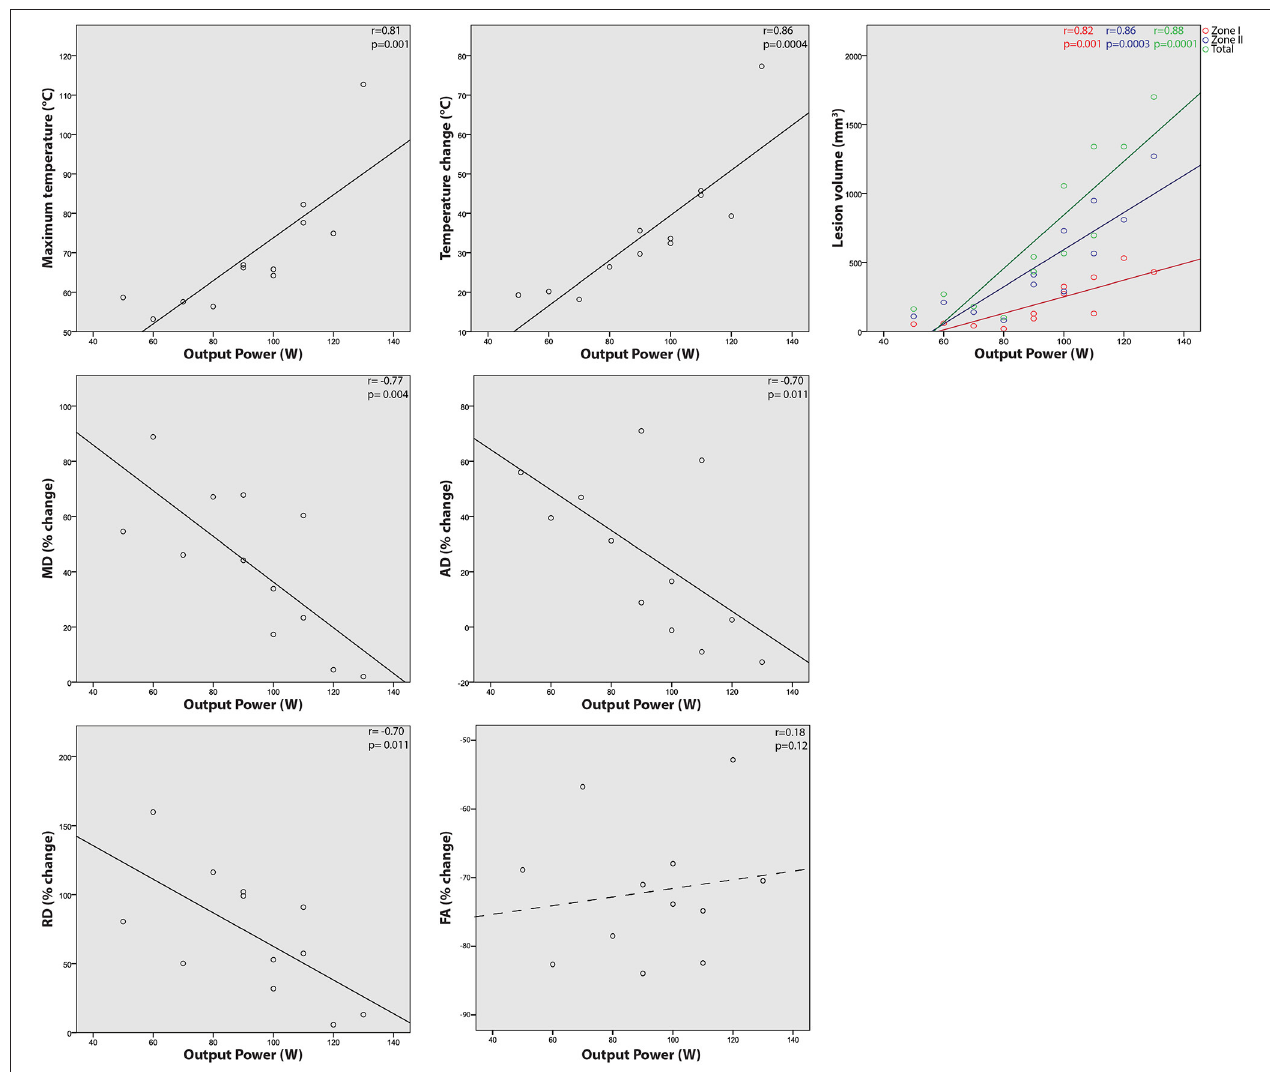
FIGURE 5 | Relationships between single sonication MRgFUS output and treatment results. Correlations are shown between transducer output power and resulting maximum temperature, temperature change from baseline, percent change in fractional anisotropy (FA), mean (MD), axial (AD), and radial diffusivity (RD), and lesion volume (zone I, II, and